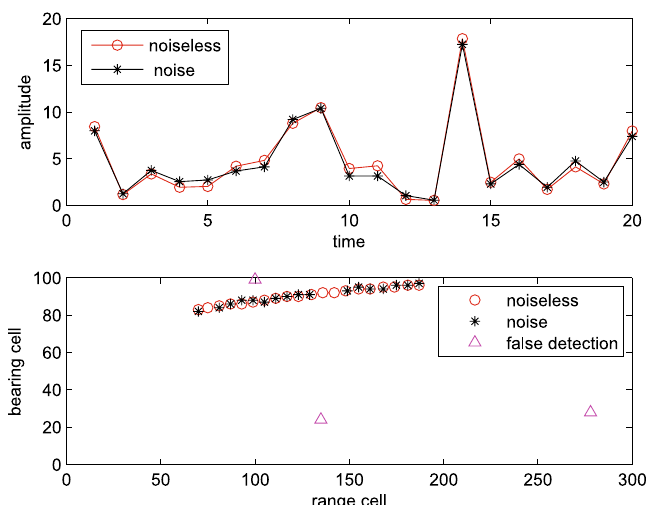
Fig. 3 The schematic diagram of the target amplitude. Top: Target amplitude fluctuation. Bottom: The highest echo intensity